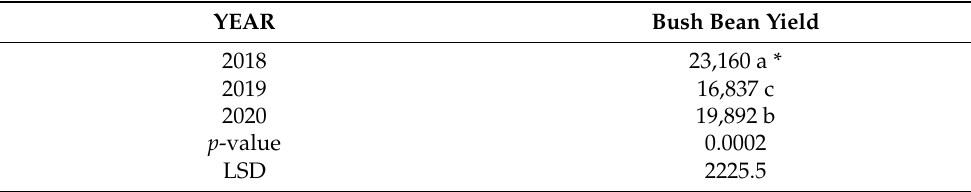
Table 10. Bush bean yield (kg ha − 1 ) at each growing season averaged over rolling treatments.